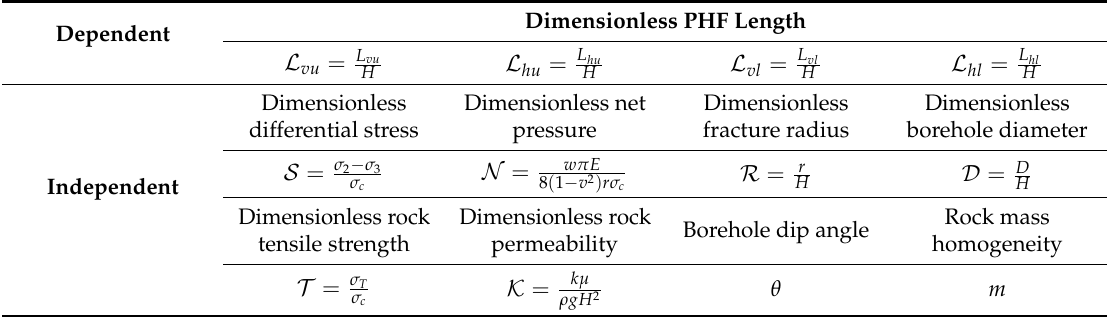
Table 5. Dimensionless relation between factors in prescribed hydraulic fracturing [32].